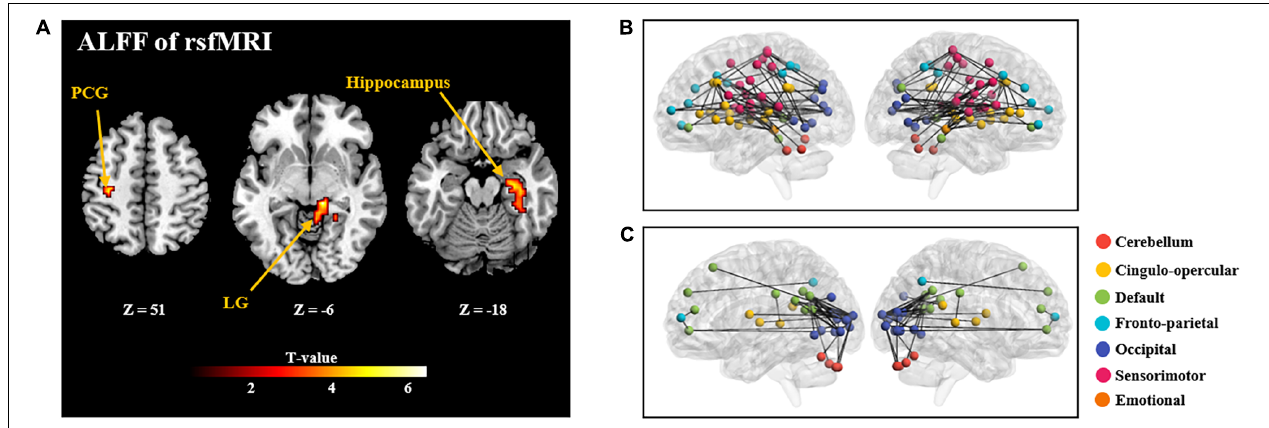
FIGURE 4 | (A) : Brain regions with rsfMRI ALFF which are significantly correlated with the NFB learning index LI ( P < 0.005, Cluster size > 50). PCG: Postcentral Gyrus; LG: Lingual Gyrus. (B) and (C) shows the correlation coefficients between rsfMRI FC and the NFB learning index LI ( P < 0.005; (B) , positive correlations; (C) : negative correlations). In B and C , nodes of different colors represent different brain regions, and the edge thickness represents the FC